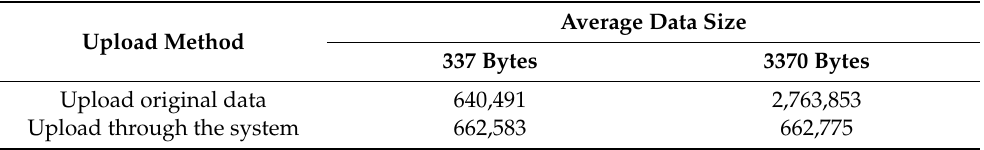
Table 1. Fuel usage comparison by upload